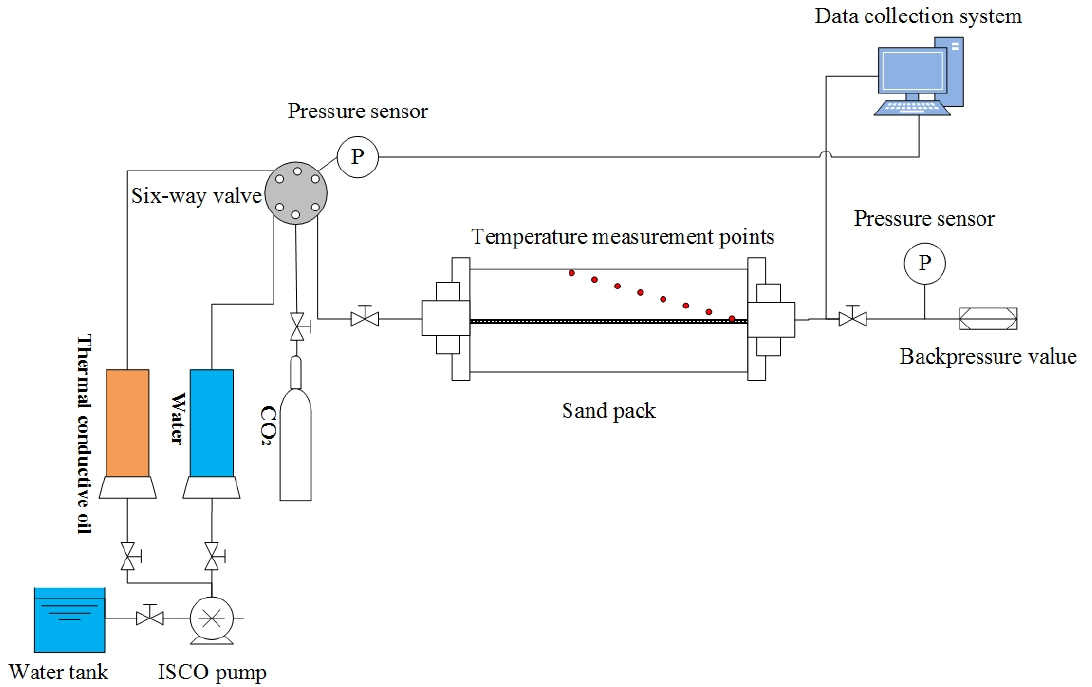
Figure 1. Schematic apparatus of the heating characteristics of wellbore fluids experiment.